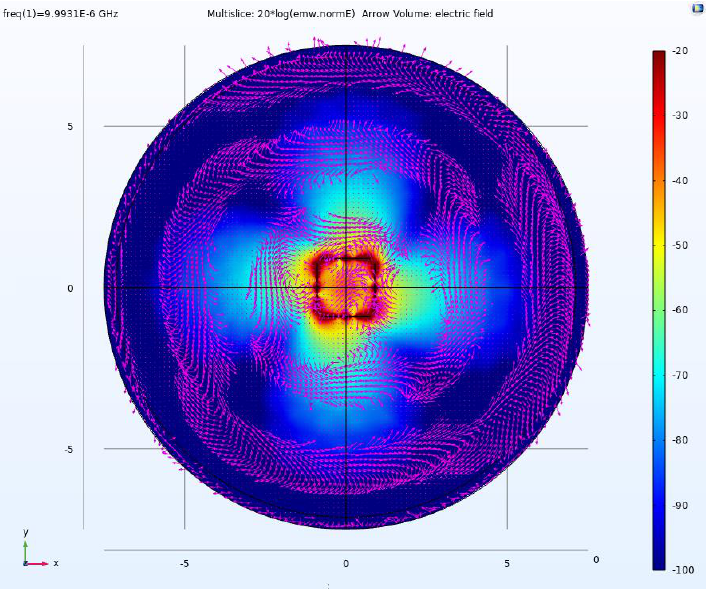
Figure 14. Electric field distribution and direction on the MD plane.